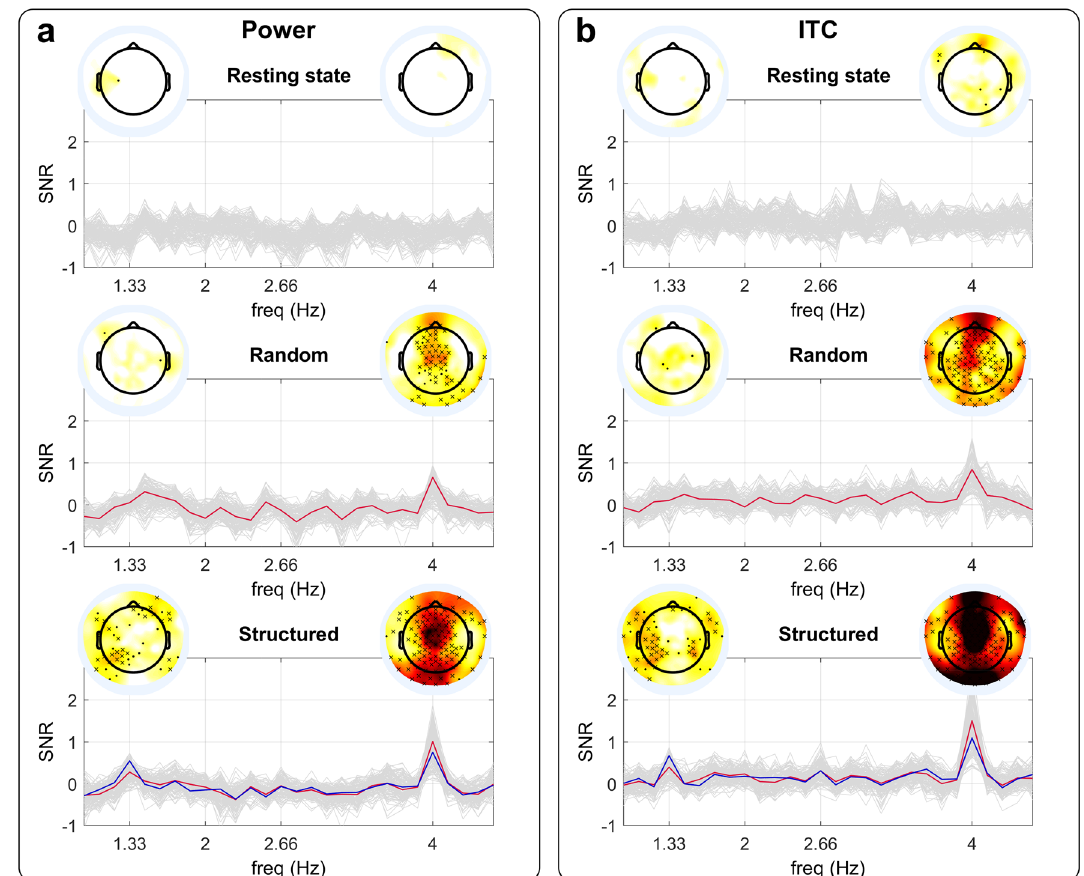
Figure 2. Neural entrainment to the syllabic rate (4 Hz) and the word rate (1.33 Hz) during the three periods (Resting state, Random stream, and Structured stream). ( a ), SNR for the power. In light gray, the entrainment for all electrodes. In red, the mean over the electrodes showing significant entrainment (p < 0.05, one-sided t-test, FDR corrected) at the syllabic rate. In blue, the mean over the electrodes showing significant entrainment (p < 0.05, one-sided t-test, FDR corrected) at the word rate. The topographies represent the entrainment in the electrodes space at the word rate and at the syllabic rate. Asterisks indicate the electrodes showing enhanced neural activity (cross: p < 0.05, one-sided t-test, FDR corrected; dot: p < 0.05, one-sided t-test, without FDR correction). ( b ), Same as ( a ) for